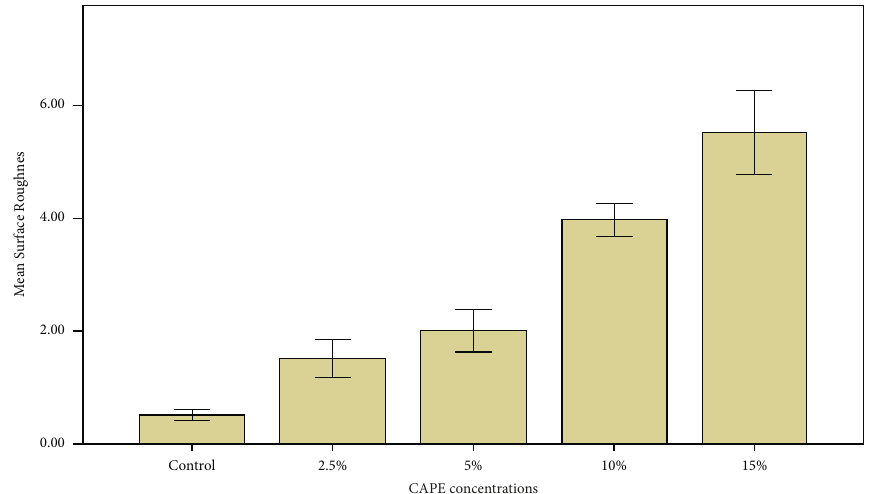
Figure 2: Effect of CAPE concentration on denture acrylic base presented by mean surface roughness ( µ m).